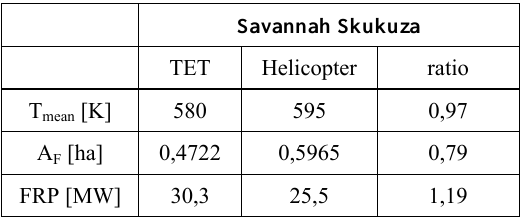
Table 3: HTE parameters, derived from a TET-1 scene compared to helicopter based parameter estimation).